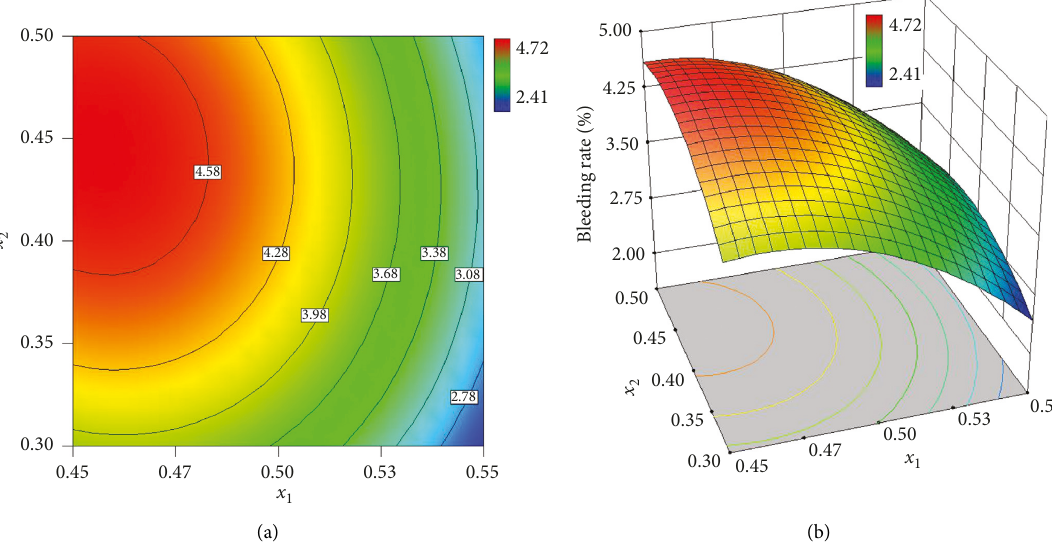
Figure 11: Interaction influence of x 1 and x 2 on bleeding ratio. (a) Two-dimensional diagram. (b) Three-dimensional